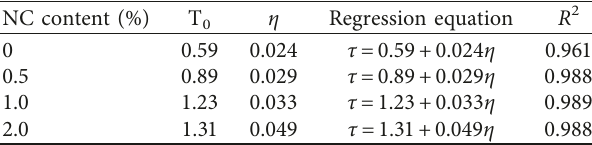
Table 3: Rheological properties of fresh